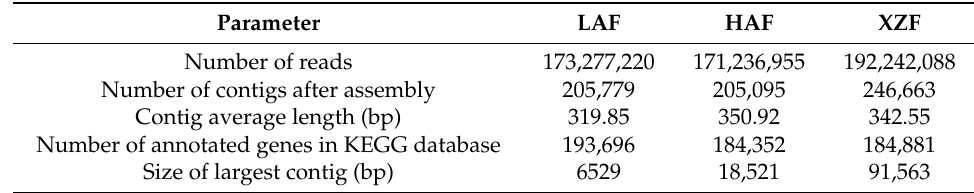
Table 1. Main values of the assembly process with the number of reads, contigs and annotated genes. LAF, lowest altitudinal forest; HAF, high altitudinal forest; and XZF, expansion zone